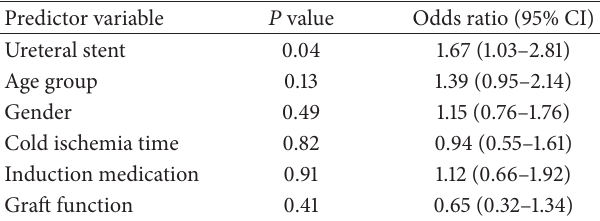
Table 3: Logistic model for